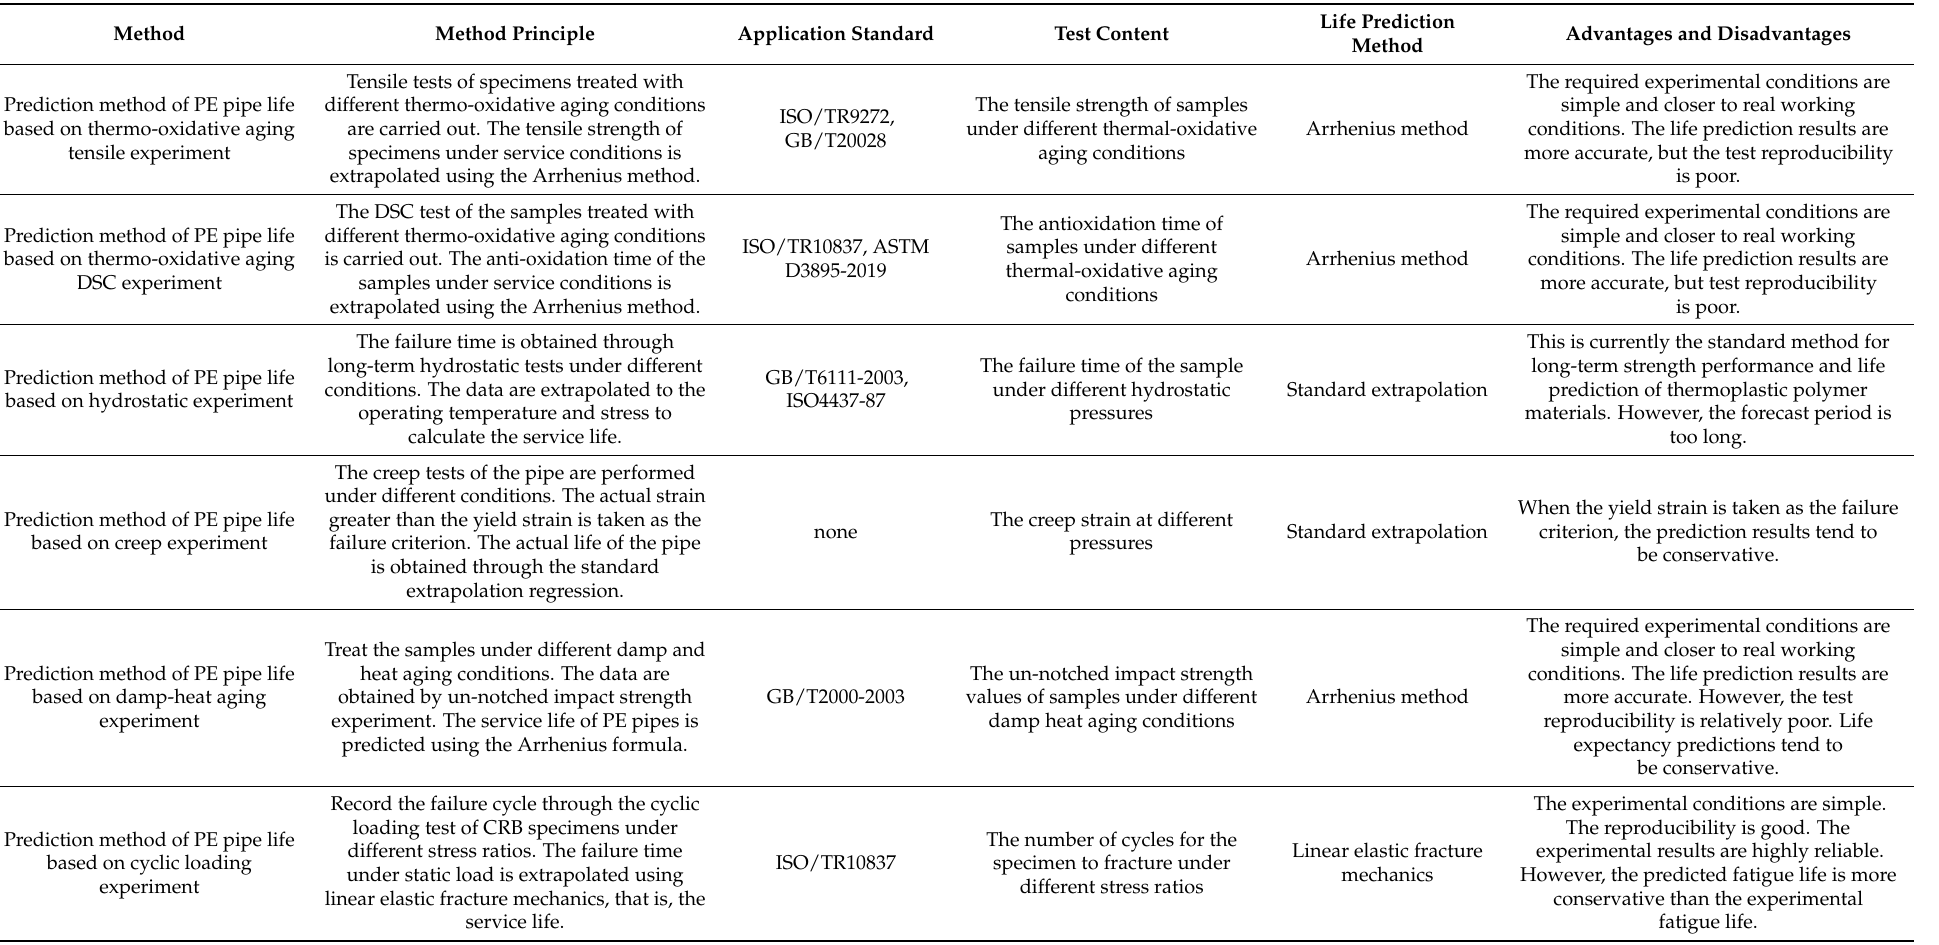
Table 1. Comparison of life prediction methods for PE